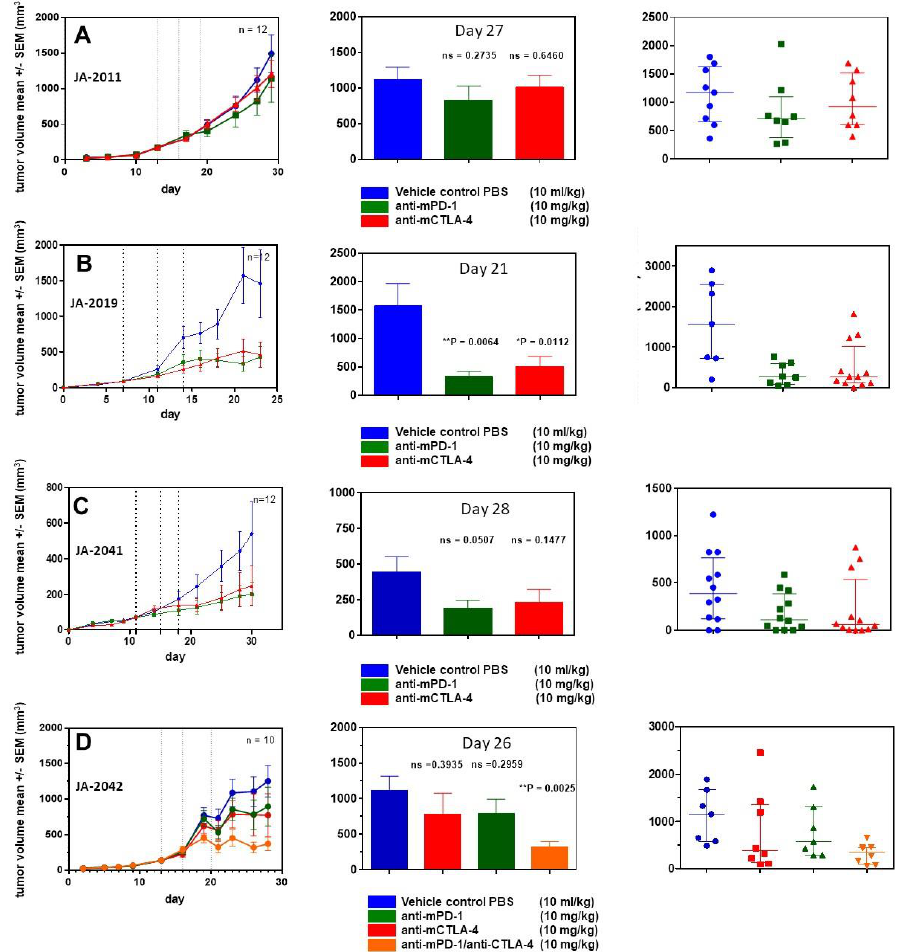
Figure 5. Efficacy studies of selected cMDI models using immune checkpoint inhibitor antibodies. Efficacy of immune checkpoint inhibitor antibodies (anti-PD-1, anti-CTLA-4, or combinations thereof) was investigated in four selected cMDI models ( A ) JA-2011, ( B ) JA-2019, ( C ) JA-2041, and ( D ) JA-2042. Ten to 12 sex-matched CBA/J mice per group were treated three times (details of treatment schedule — see Material and Methods) with antibodies or PBS as vehicle control (dotted lines). Results are shown as mean (curve and bar graphs) and individual values of single mice (dot plots) with standard error of the mean (SEM). Probability ( p ) was tested with a parametric unpaired t test (GraphPad Prism 5.04) as compared to PBS vehicle control. Differences were determined as not significant with ns > 0.050 and significant * with p < 0.050, ** with p < 0.010, or *** with p < 0.001.